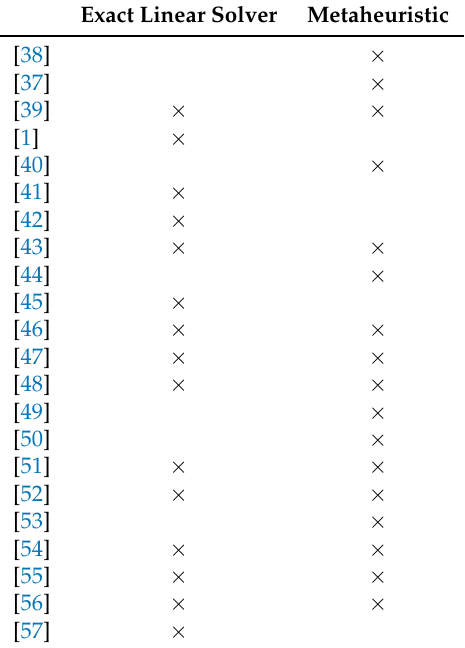
Table 5. Cont. Exact Linear